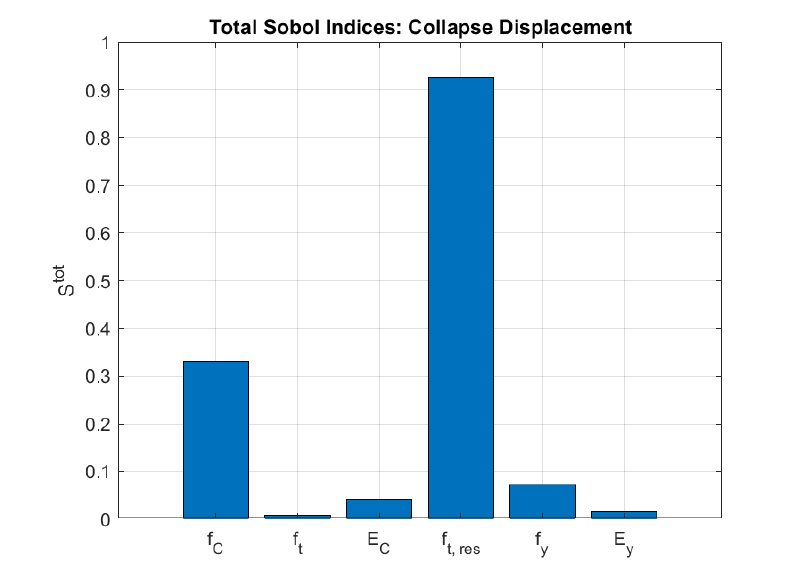
Figure 18. Total Sobol’ indices for collapse